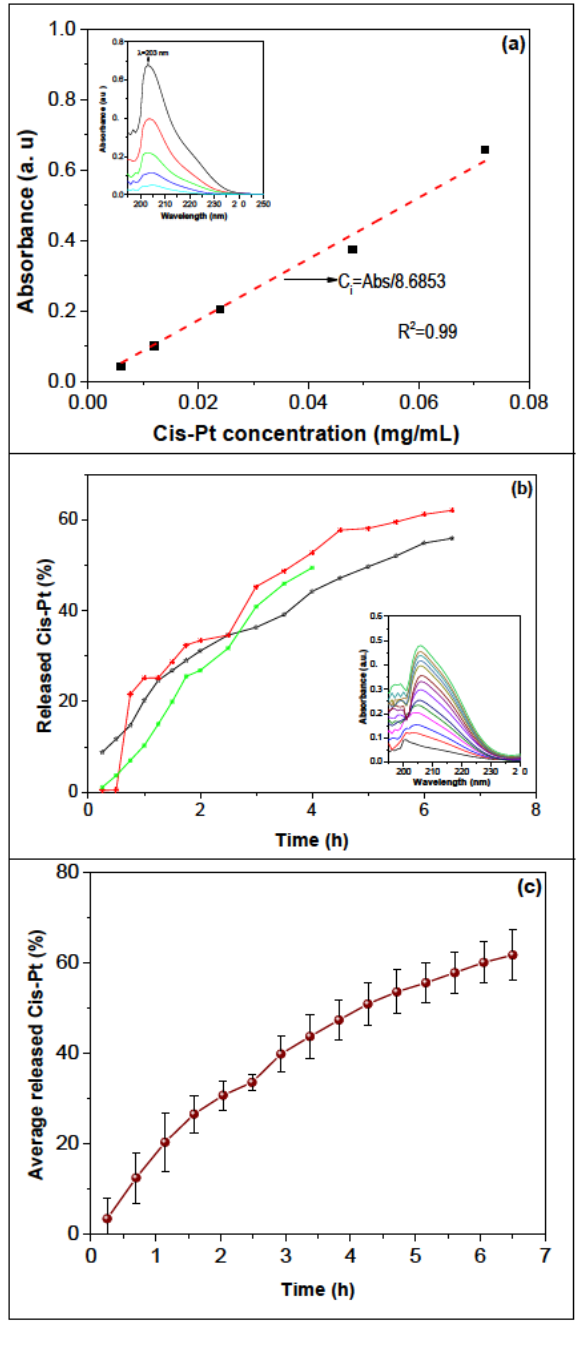
Figure 6: (a) Calibration curve constructed from the absorbance at λ =203 nm of the spectra shown in the insert vs. concentration of Cis-Pt, (b) Triplicate in vitro release Cis-Pt profiles, insert shows the characteristic spectra of Cis-Pt obtained during the tests, and (c) Averaged Cis-Pt release